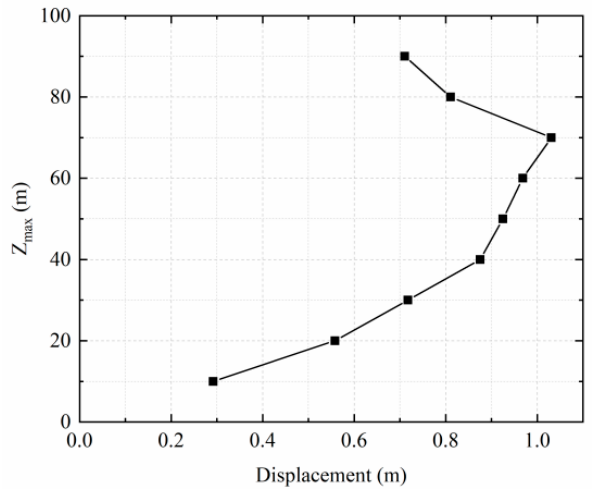
Figure 16. Tip displacement under different Z max.